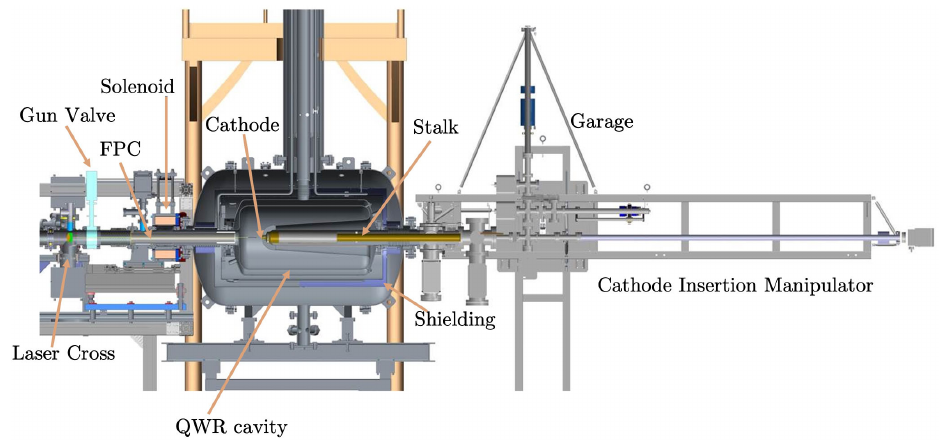
FIG. 1. Schematic of the CeC SRF gun assembly indicating the major system